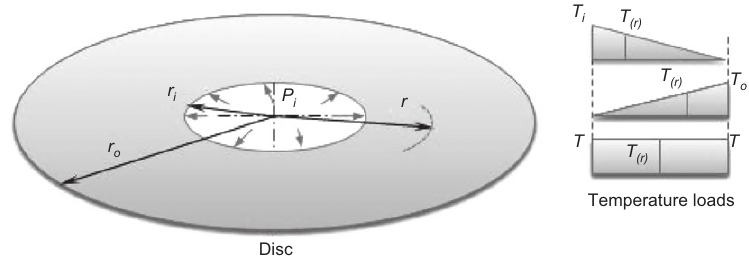
Figure 1 A functionally graded disc under internal pressure and various temperature